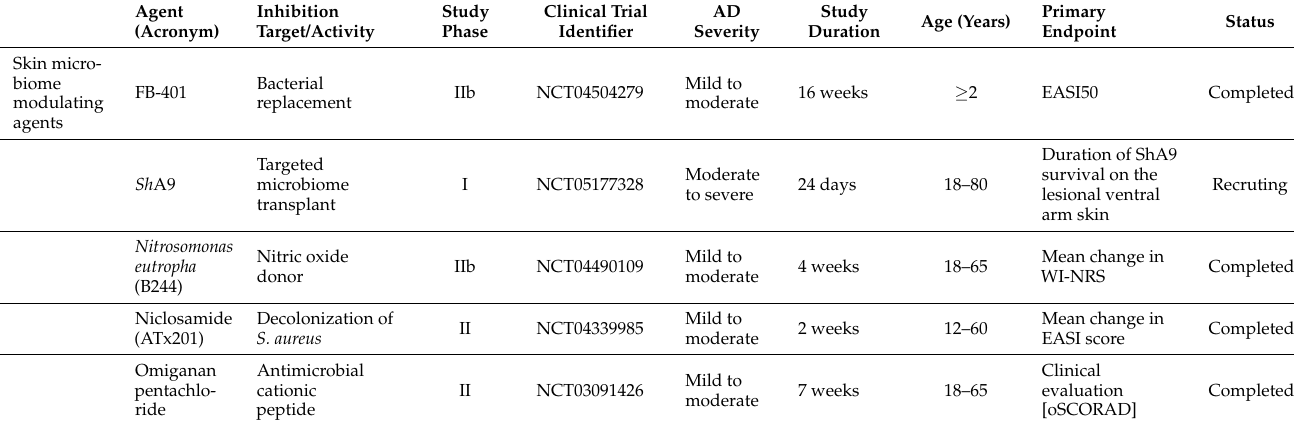
Table 2. Other novel topical therapies currently in phase I/II of development for atopic